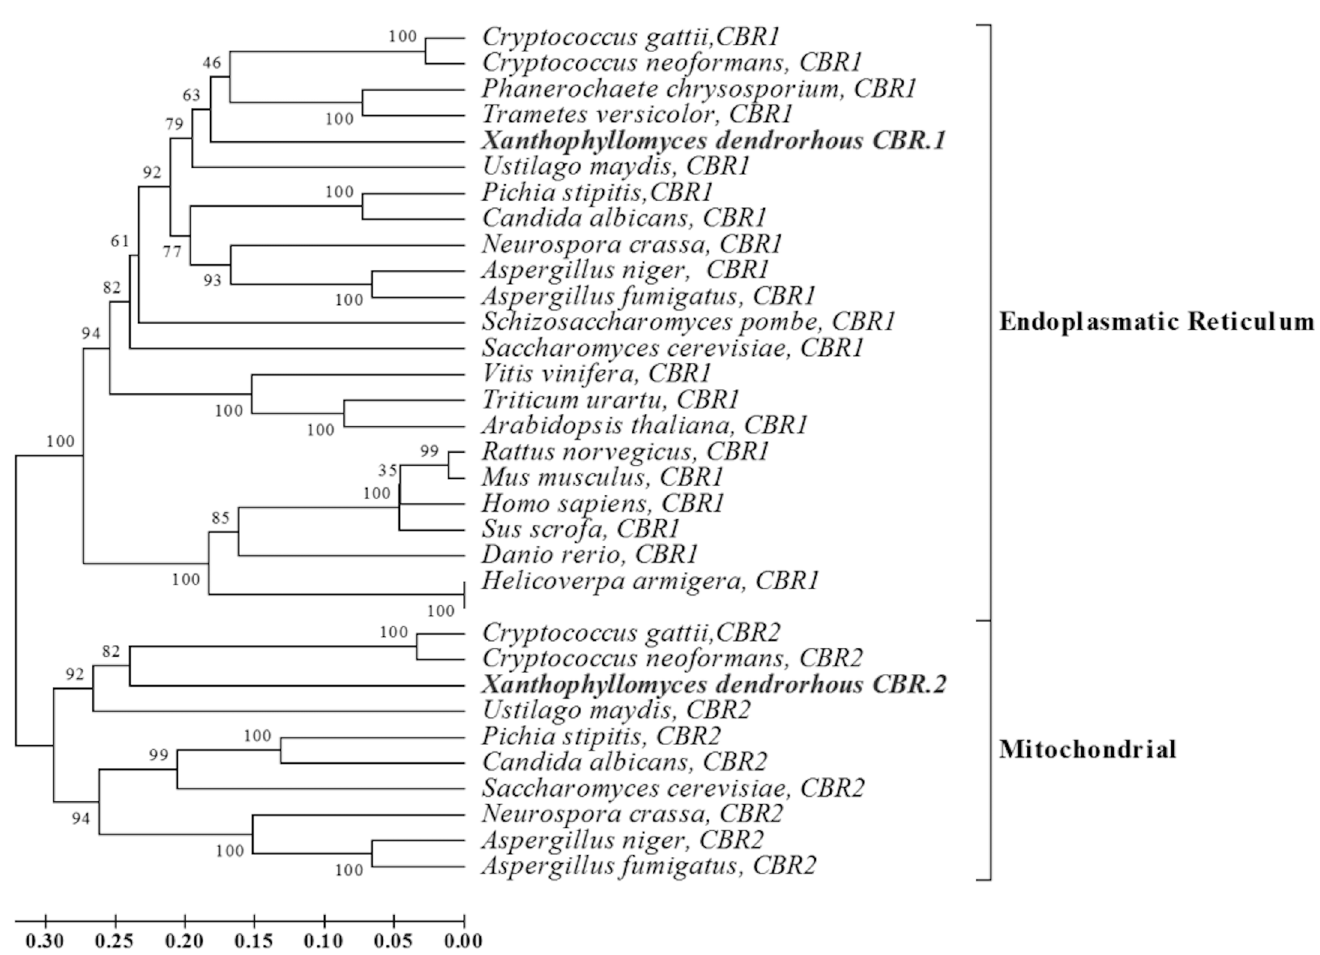
Fig 3. Phylogenetic analysis of the CBR genes from X . dendrorhous . The accession numbers for each of the amino acid sequences are: Cryptococcus gattii CBR1 [E6REZ8] and CBR2 [E6REQ5], C . neoformans CBR1 [P0CP14] and CBR2 [J9VWT4], P . chrysosporium CBR1 [E2QDB5], T . versicolor